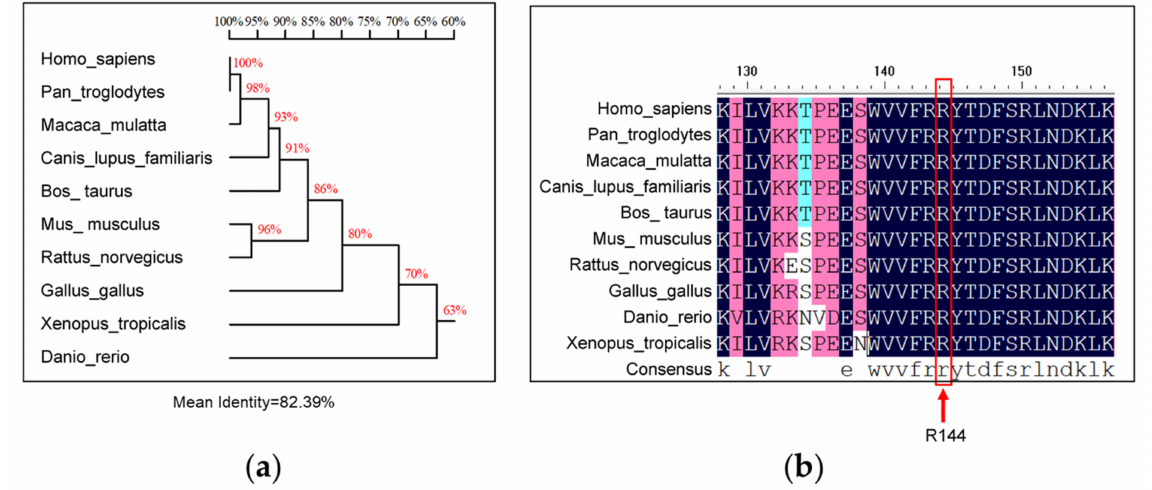
Figure 5. Homology analysis of residue R144 of SNX16. The amino acid sequences of SNX16 protein of different species from NCBI were aligned by using DNAMAN software to show homologies of SNX16 ( a ) and the conservativeness of residue R144 ( b ).